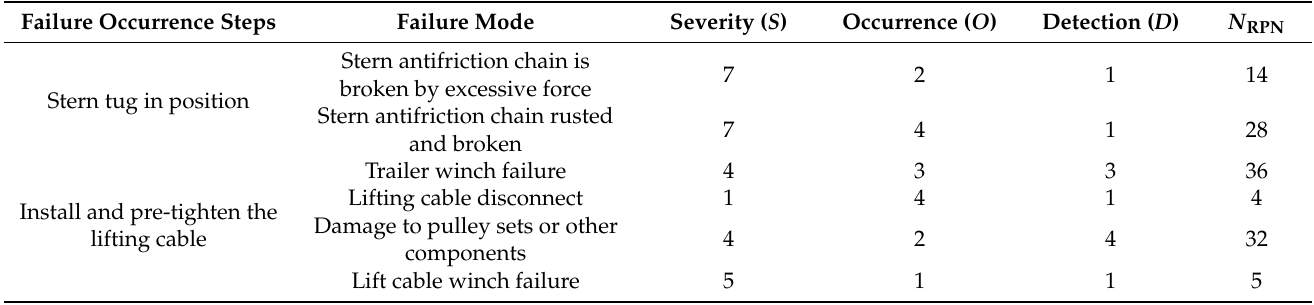
Table 2. Cable limiting